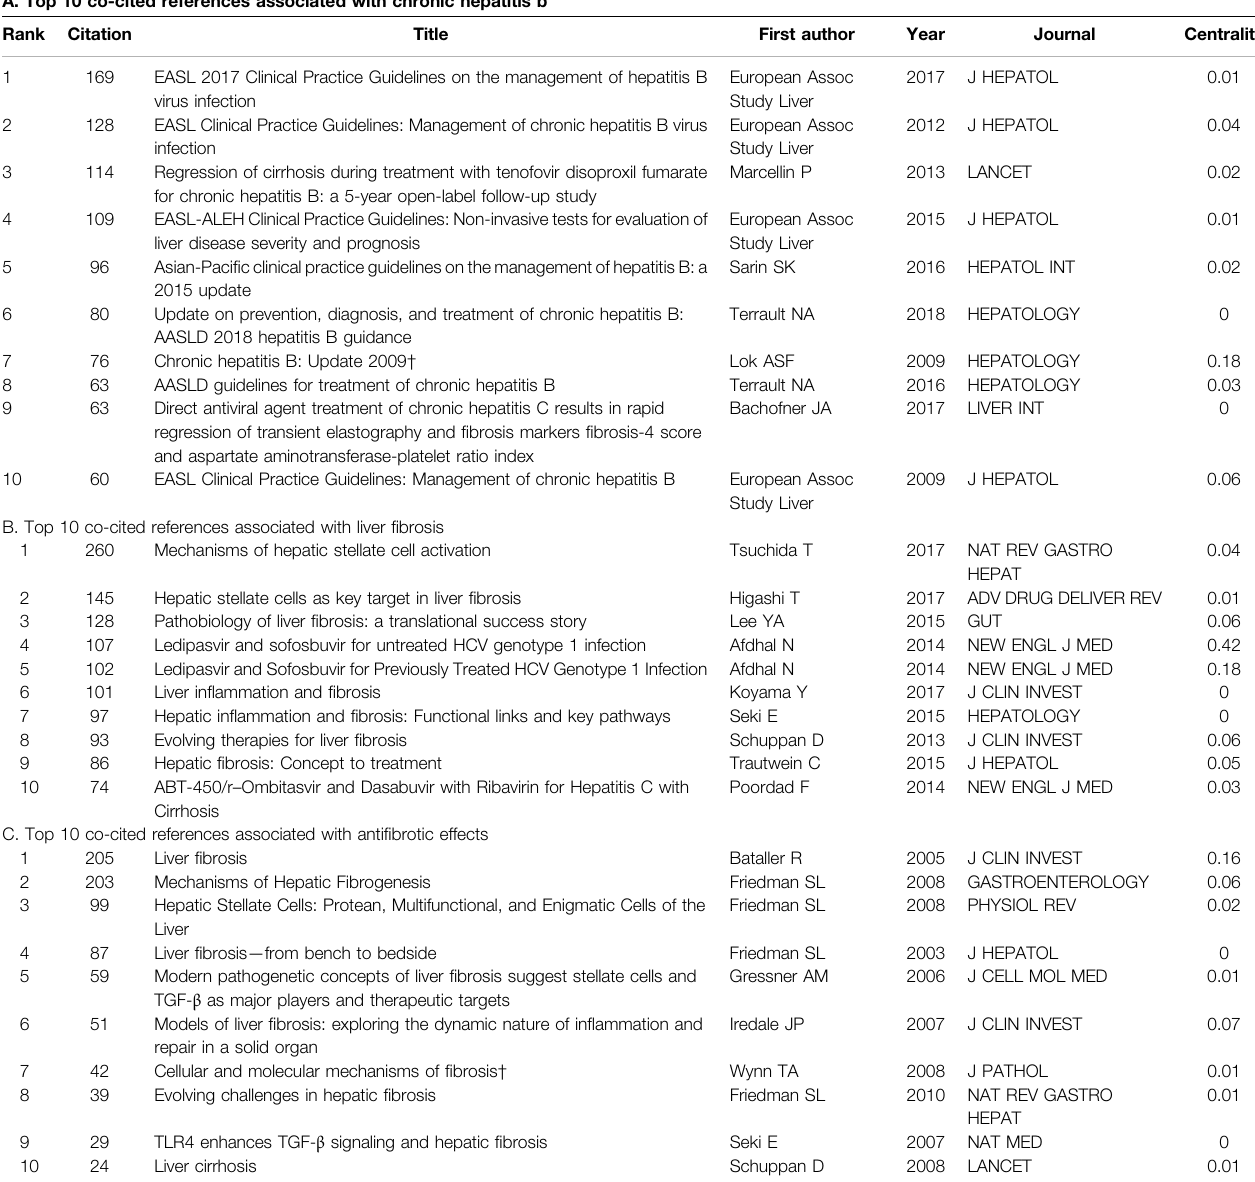
TABLE 5 | The top 10 co-cited references associated with the treatment of liver fi